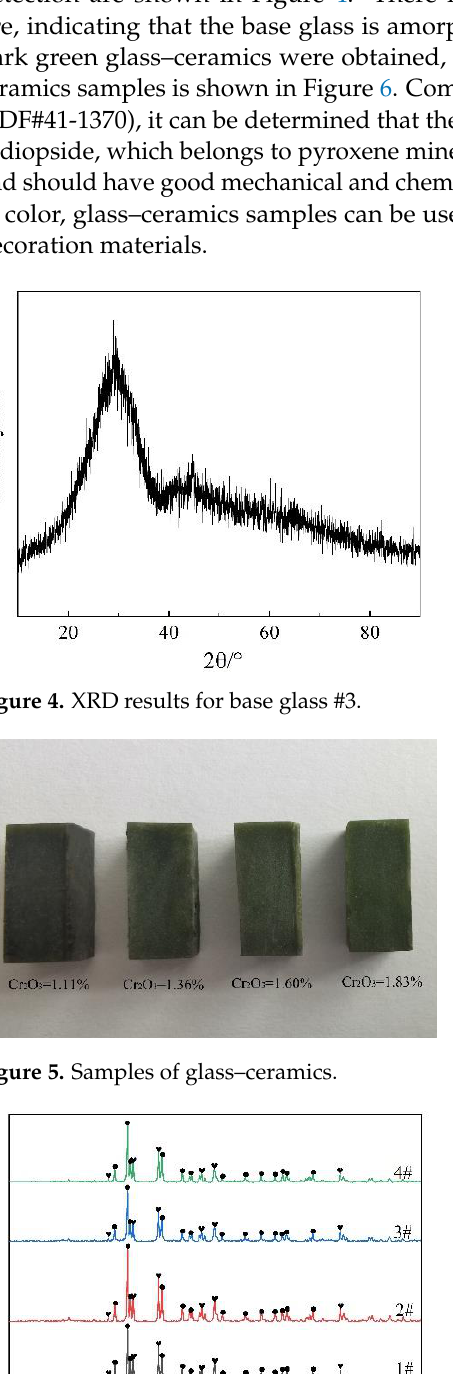
Figure 3. XRD results of A and B experiments.